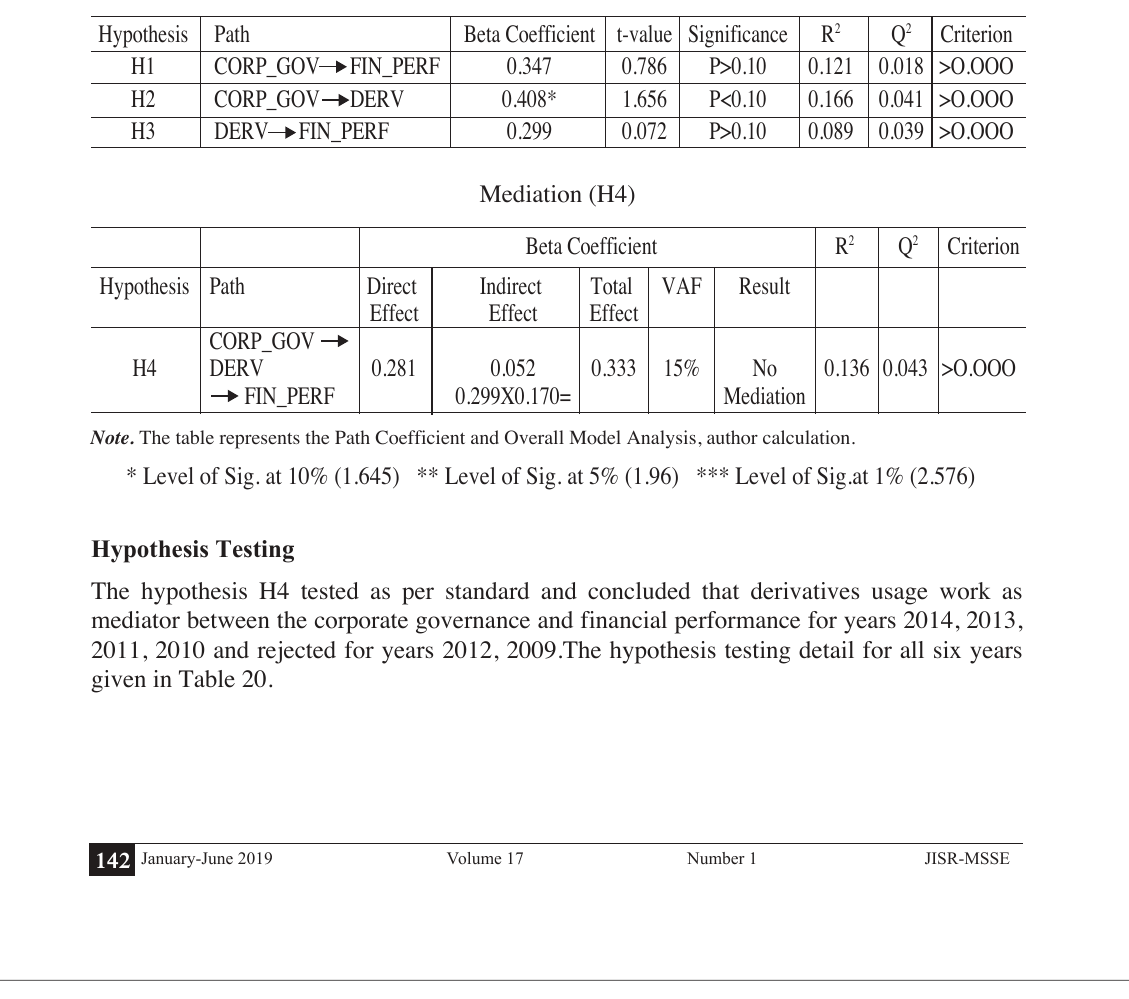
Table 19: Conditions of Mediation (H1 to H3)